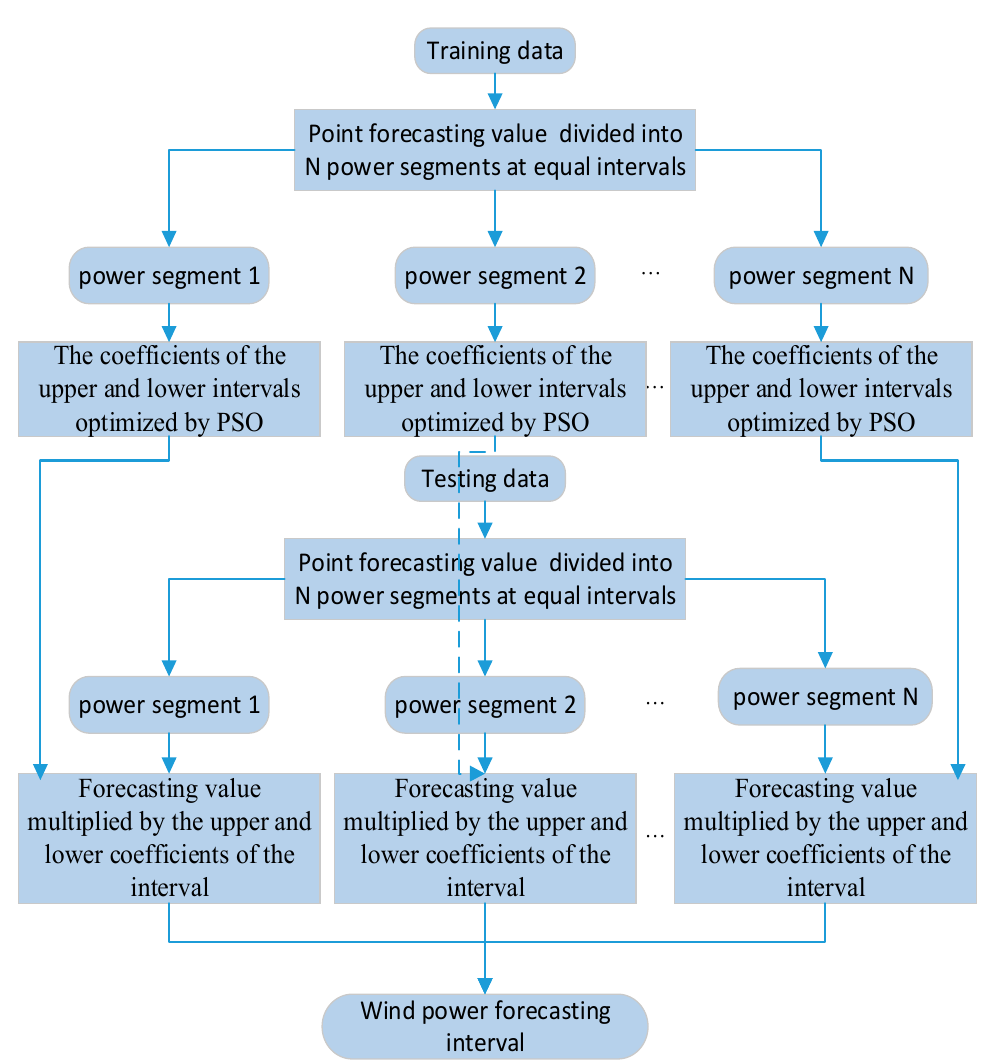
Figure 4. The overall architecture of the proposed approach for probabilistic wind power forecasting.